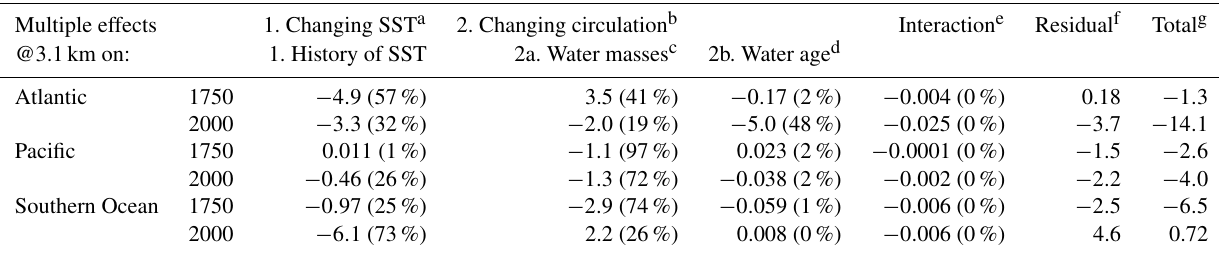
Table B3. Summary of quantification of how different effects act on the deep ocean temperature at 3.1km, per basin and at times of interest 1750CE and 2000CE. All values are temperature anomalies with respect to 1200CE in centi-Kelvin (cK). Percentages are added in parentheses, where the residual is excluded; i.e. 100% corresponds to the sum of effects 1, 2a, 2b and their interaction. For the percentage, the absolute value of each contribution is taken.